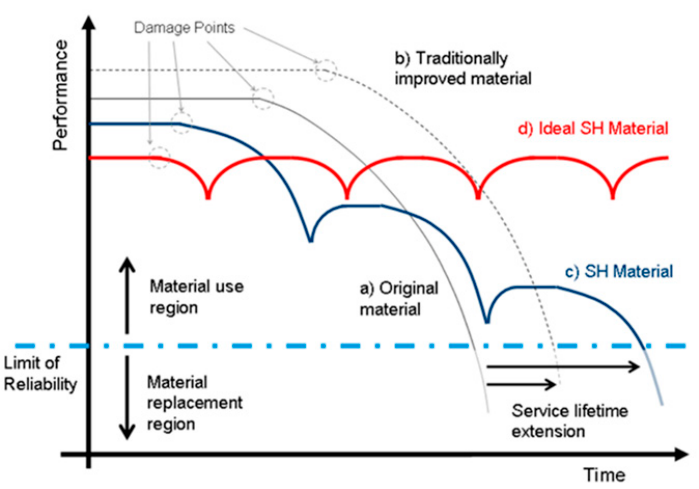
Figure 1. Lifetime extension of engineered materials by implementation of self-healing principles. (reproduced from [5] with permission from Elsevier).